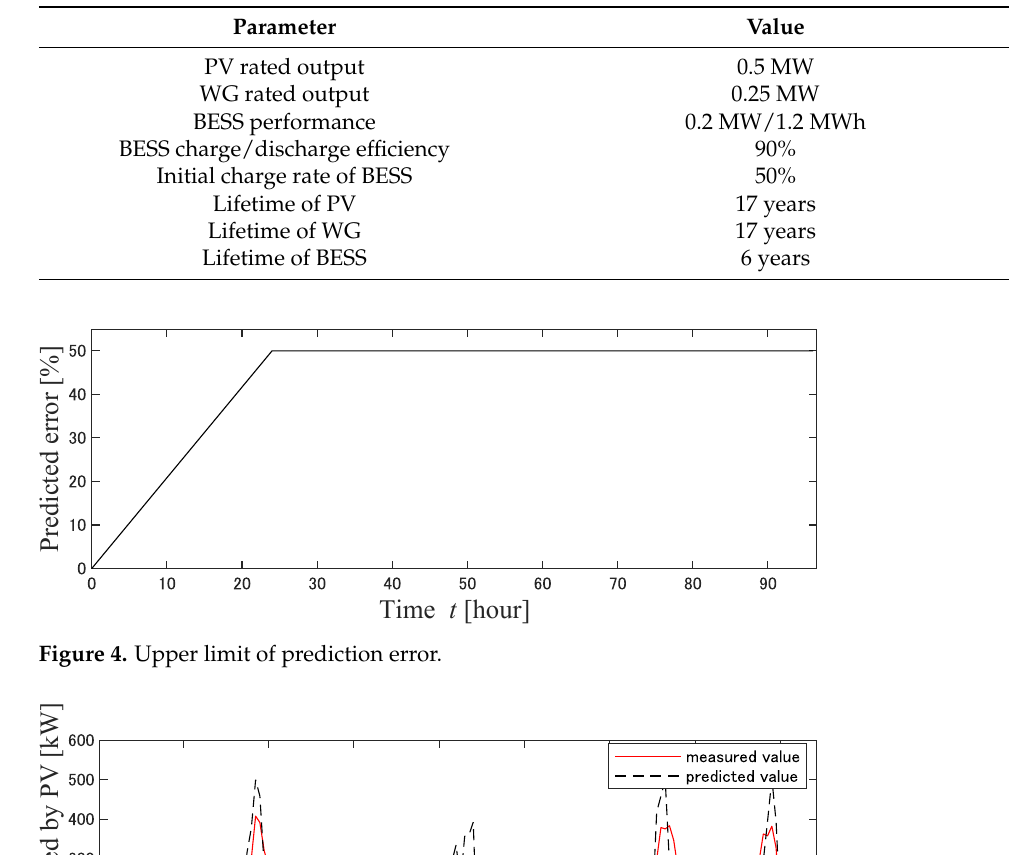
Table 1. Specifications of each power generation facility and storage battery.